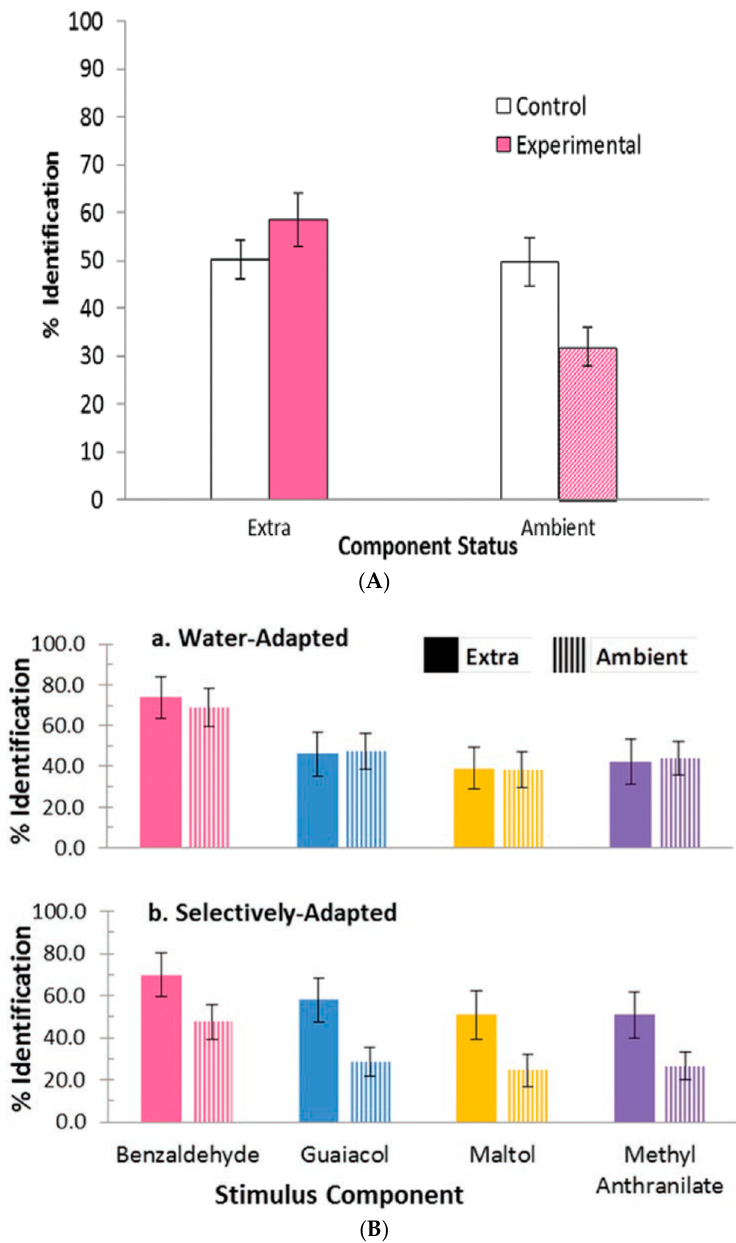
Figure 5. Selective adaptation of cherry, smoke, caramel and grape odors in 2, 3, and 4 component mixtures replicates the results shown in Figure 4 for alcohol, vanilla, mint and rose in spite of benzaldehyde cherry-odor dominance. From [28] with permission of Oxford University Press. ( A ) Results for a second foursome of odors: cherry, smoke, caramel, and grape replicate first shown in Figure 4. Experimental: selectively adapted (rose-colored bars). Control: water-adapted (white bars). (B ) Although benzaldehyde dominates water-adapted mixtures ( a ); extra components dominate selectively-adapted mixtures ( b ).